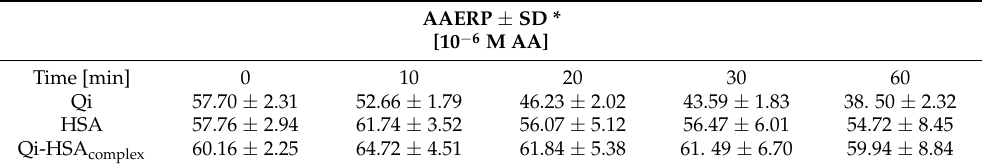
Table 7. The total AAERP antioxidant capacity (FRAP assay); pH =